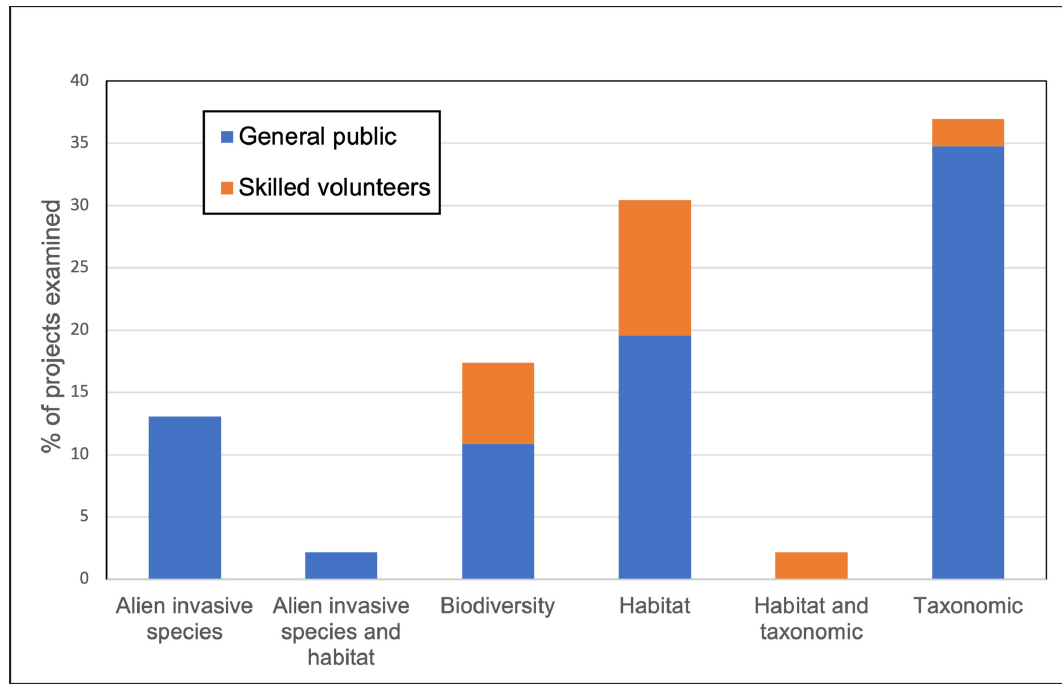
Figure 2 Summary of Irish marine and freshwater citizen science programmes and level of skill required (n =